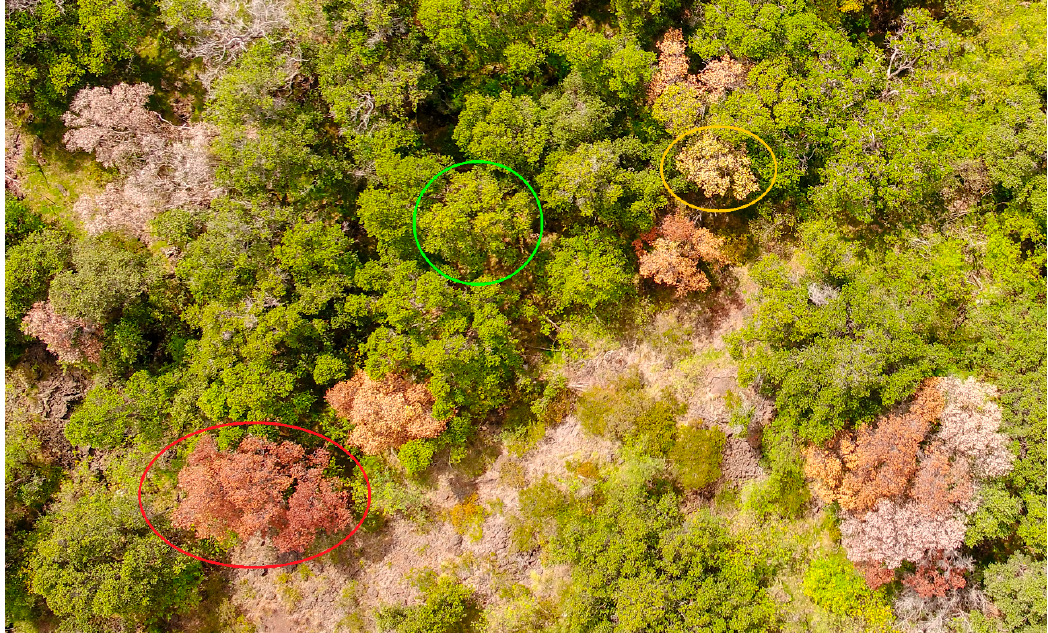
Figure 1. Small unmanned aerial system (sUAS) image (October 9, 2017, taken at 12:58 Hawaii Standard Time (HST) at 120 m altitude) showing “rapid ‘ ō hi‘a death” (ROD)-affected ‘ ō hi‘a trees on Hawai‘i Island (19°22'13"N, 155°22'20"W) in various stages of expression of visible symptoms. Colored circles depict example asymptomatic (green), early onset (yellow), and late stage (red) ‘ ō hi‘a trees.